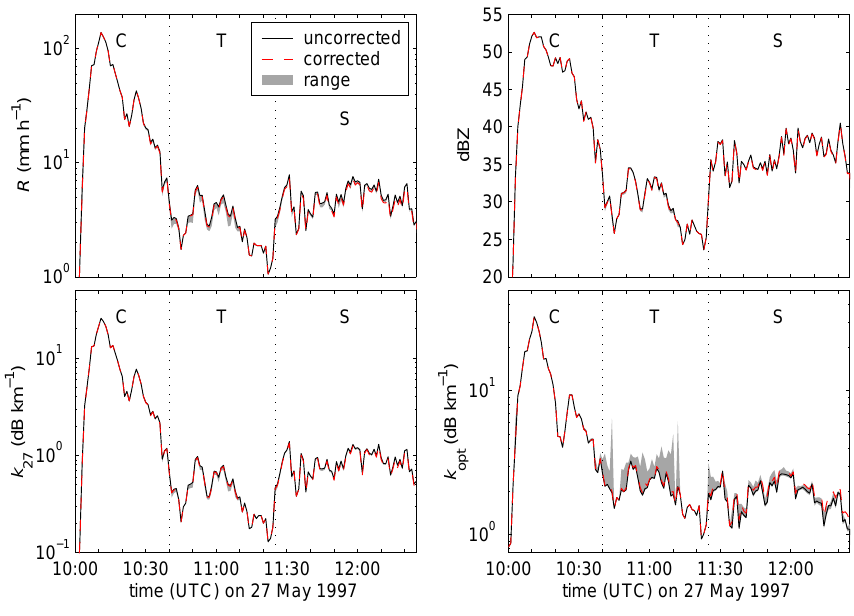
Fig. 3. Timeseries of bulk rainfall variables ( R , Z , k 27 , and k opt ) derived from the Goodwin Creek JWD dataset for the event of May 27, 1997, with the convective (C), transition (T), and stratiform (S) regions (Uijlenhoet et al., 2003) indicated. The variables are computed from uncorrected and corrected DSDs, where the three methods of correcting described in Sect. 3.1 are depicted. Method (1) corresponds to the dashed red line (corrected), and the range between methods (2) and (3) is depicted by the shaded ares